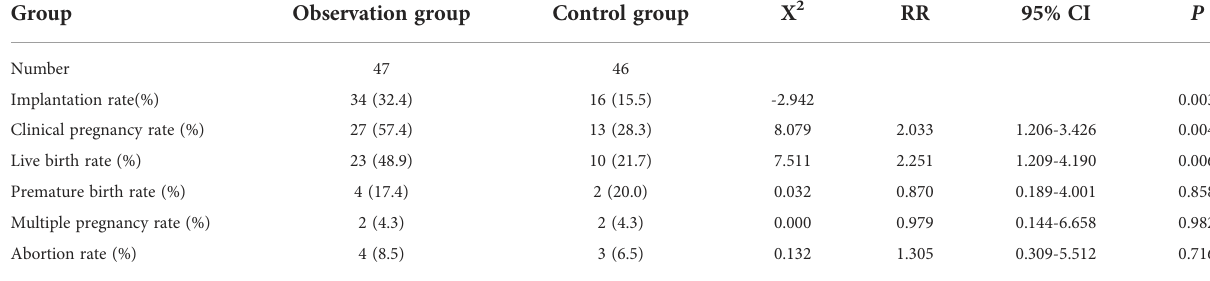
TABLE 2 Comparison of clinical outcomes between two groups of patients.